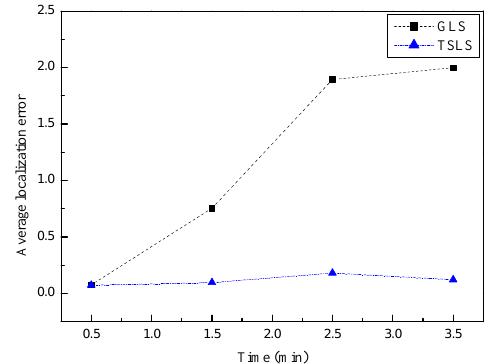
Fig.7. Average localization error of unknown nodes when changing the status of beacon nodes.